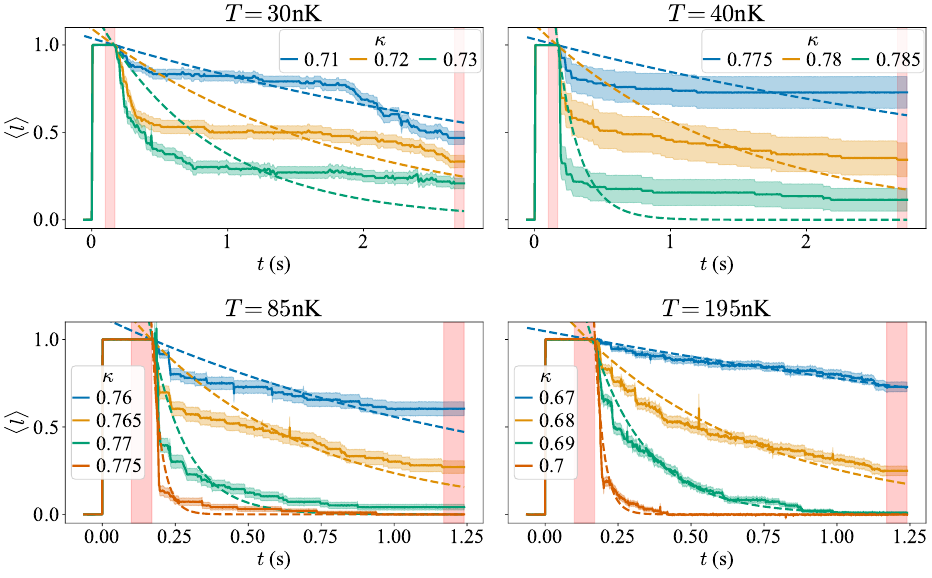
Figure 5: Average winding number as a function of time, for different temperatures and barrier heights, which are scaled by the chemical potential, κ = V bars give a 95% confidence interval based on the standard error. The period of time t < 0 corresponds to initial state generation, with quantum fluctuations and 2 π phase winding imprinted at t = 0. Vertical red shaded regions denote ramping- up / down of the perturbing barrier. For a given temperature, increasing the barrier height decreases the stability of the l = 1 circulation state, leading to faster decay of 〈 l 〉 . Dashed lines are fits of the form 〈 l 〉 = c data in the time period between the shaded red regions, where t taken for the barrier to reach its maximum